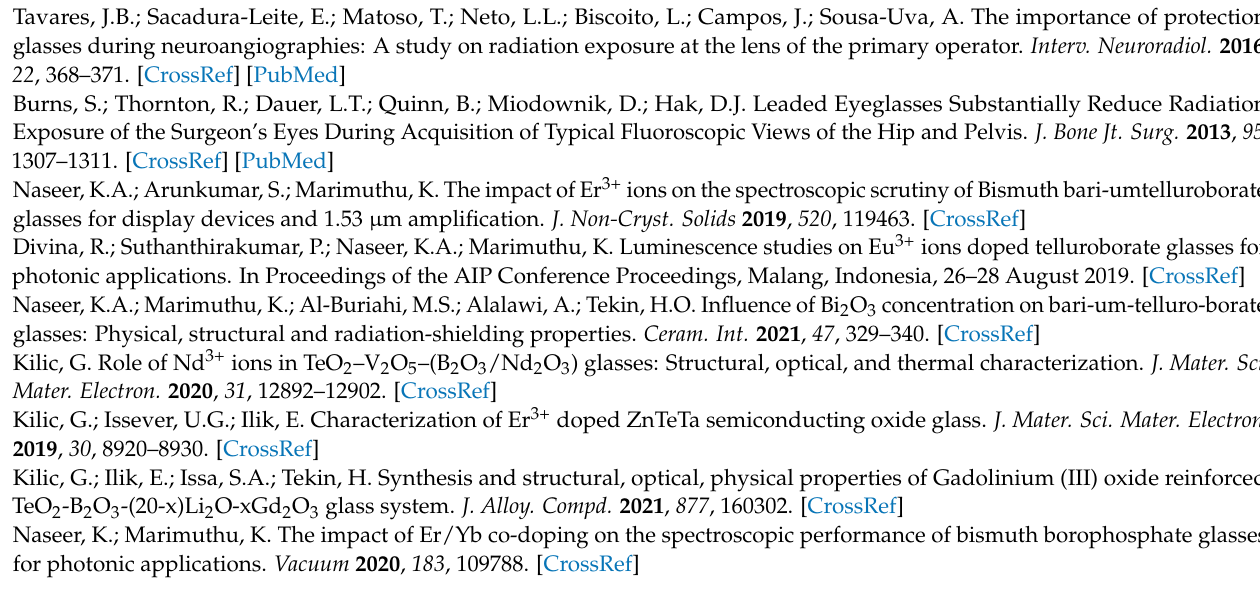
glass sample, Table S2. (EBF and EABF) G–P fitting coefficients (b, c, a, Xk and d) of AL2.5 glass sample, Table S3. (EBF and EABF) G–P fitting coefficients (b, c, a, Xk and d) of AL5.0 glass sample, Table S4. (EBF and EABF) G–P fitting coefficients (b, c, a, Xk and d) of AL7.5 glass sample, Table